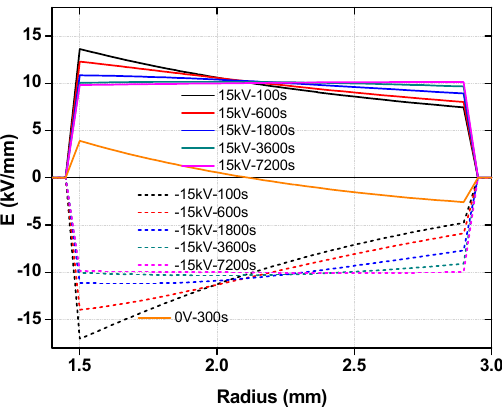
Figure 11. Field distribution profiles in a cable sample with voltage inversion applied from +15 kV to − 15 kV and at T gradient = 10 ◦ C. The curve indexed 0 V-300 s is the field distribution after 300 s in the short-circuit applied after the negative voltage step.